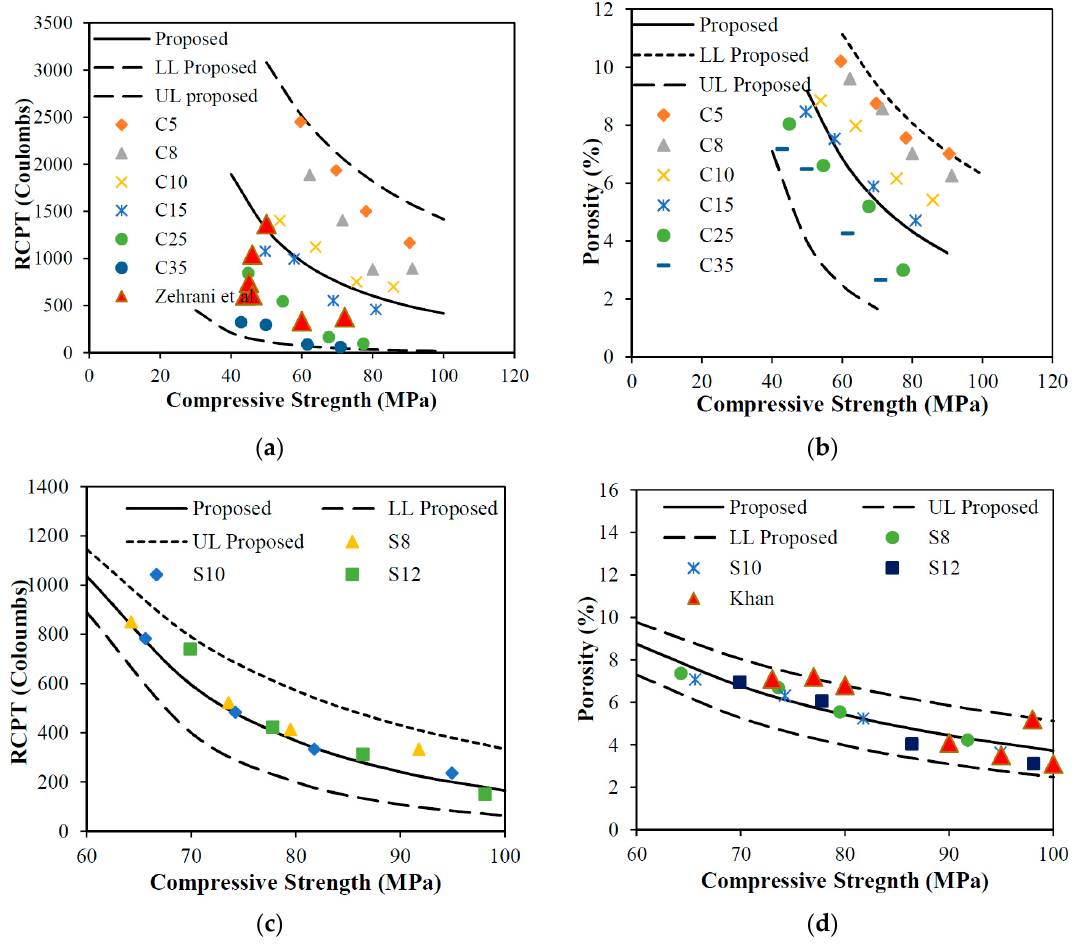
Figure 12. Compressive strength vs. permeation-related properties of SF and UF particle: ( a ) compressive strength vs. RCPT (Coulombs) relationship for different dosages UF; ( b ) compressive strength vs. porosity (%) relationship for different dosages UF; ( c ) compressive strength vs. RCPT (Coulombs) relationship for different dosages SF; ( d ) compressive strength vs. porosity (%) relationship for different dosages SF.